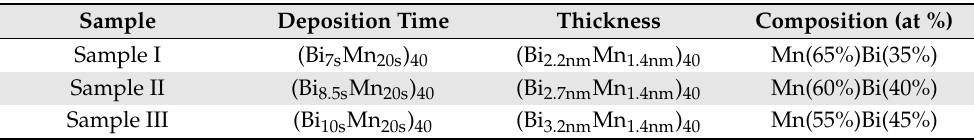
Table 1. Summary of the deposition times, thicknesses and composition of the different samples. Sample Deposition Time